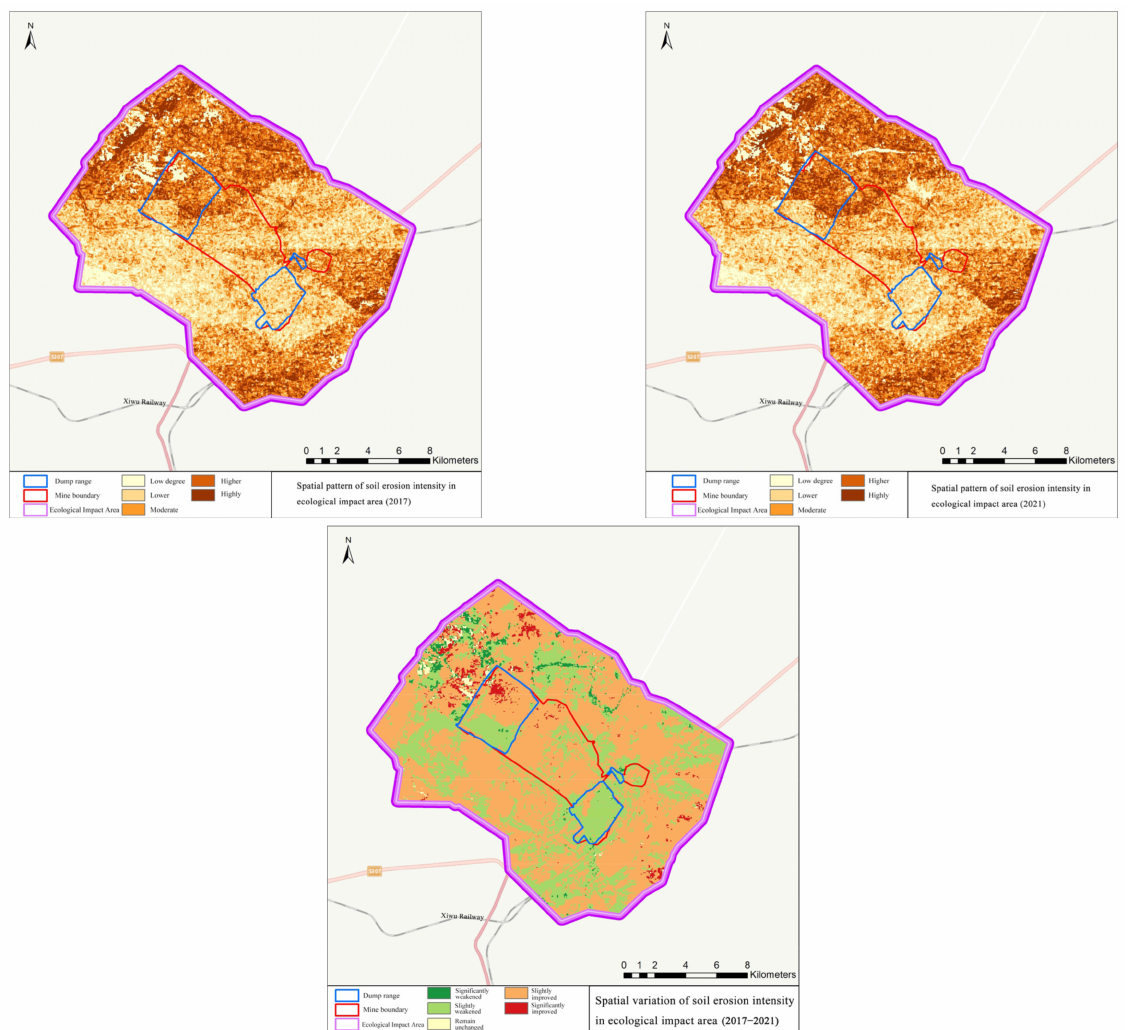
Figure 7. Spatial pattern of soil erosion intensity in the ecological impact